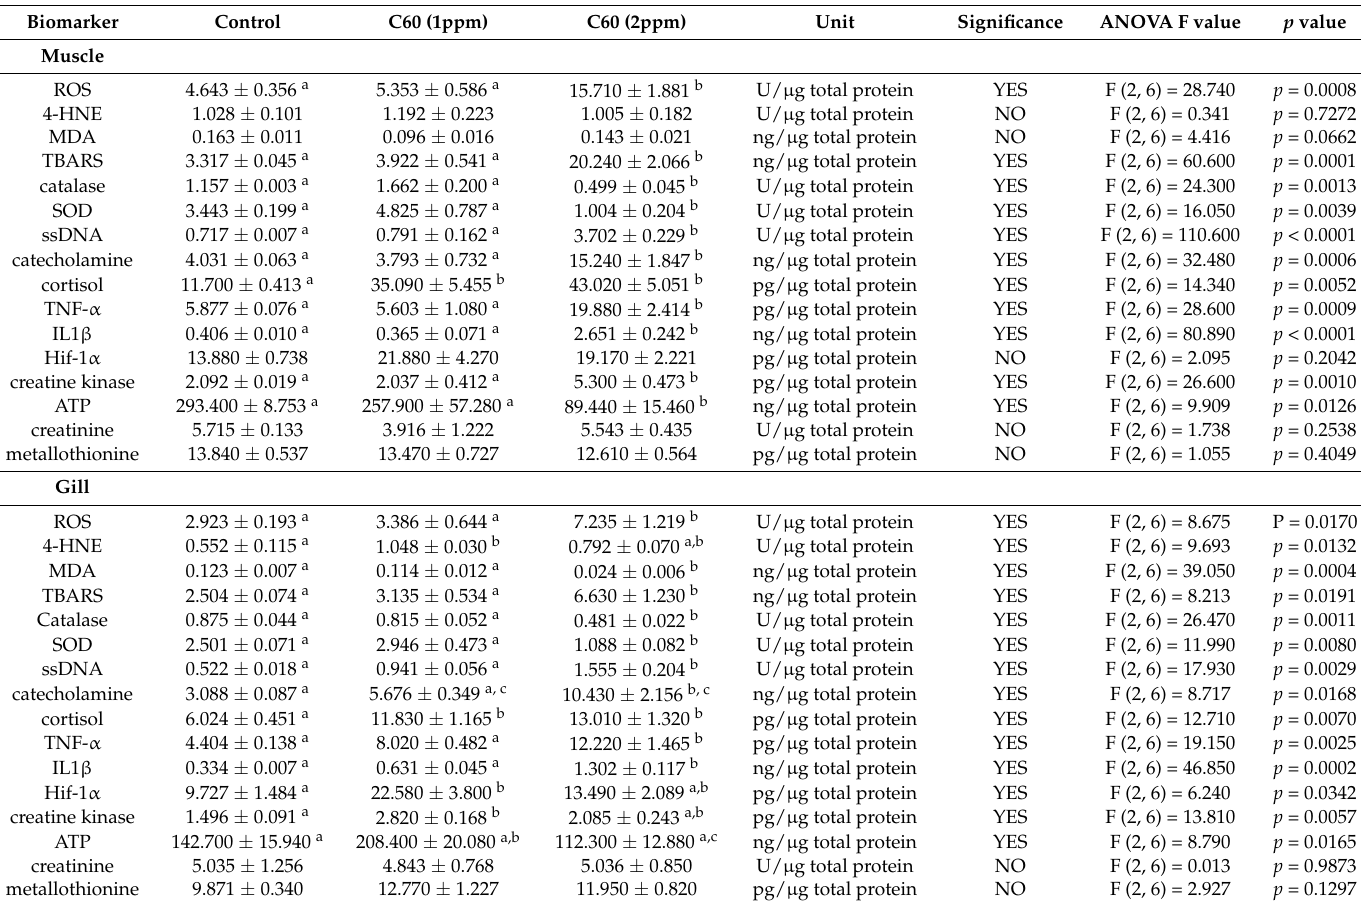
Table 1. Detection of biochemical parameters in the muscle and gill tissue for C 60 NPs-exposed zebrafish after 12-day exposure.